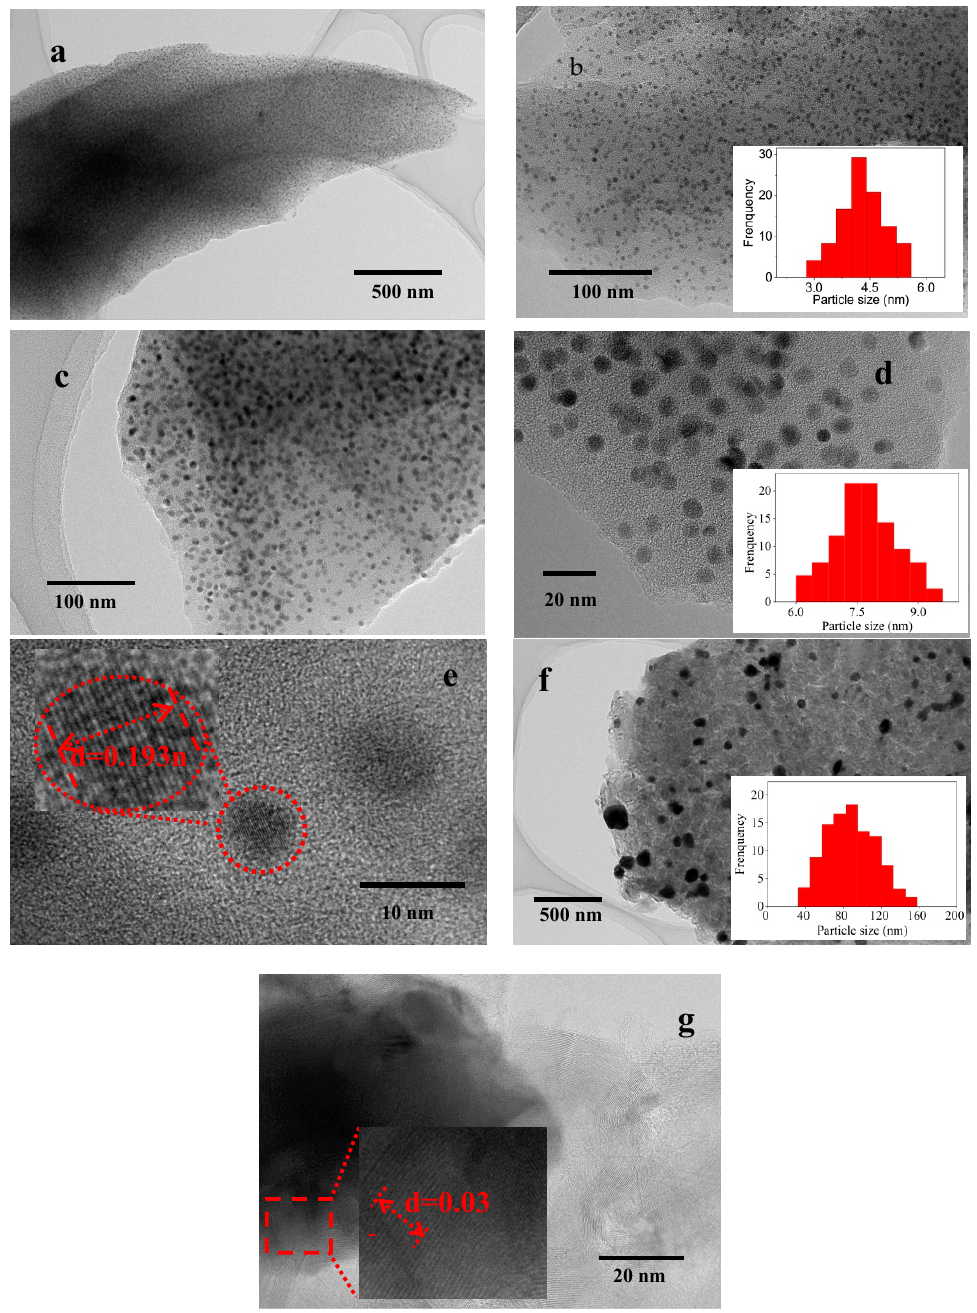
Figure 3. TEM of ( a,b ) Ni@C-700, ( c–e ) Ni@C-800, ( f,g ) Ni@C-900 (insets are the size distribution of nickel particles ( b , d , f ) and the HR-TEM micrographs of the nickel particles ( e